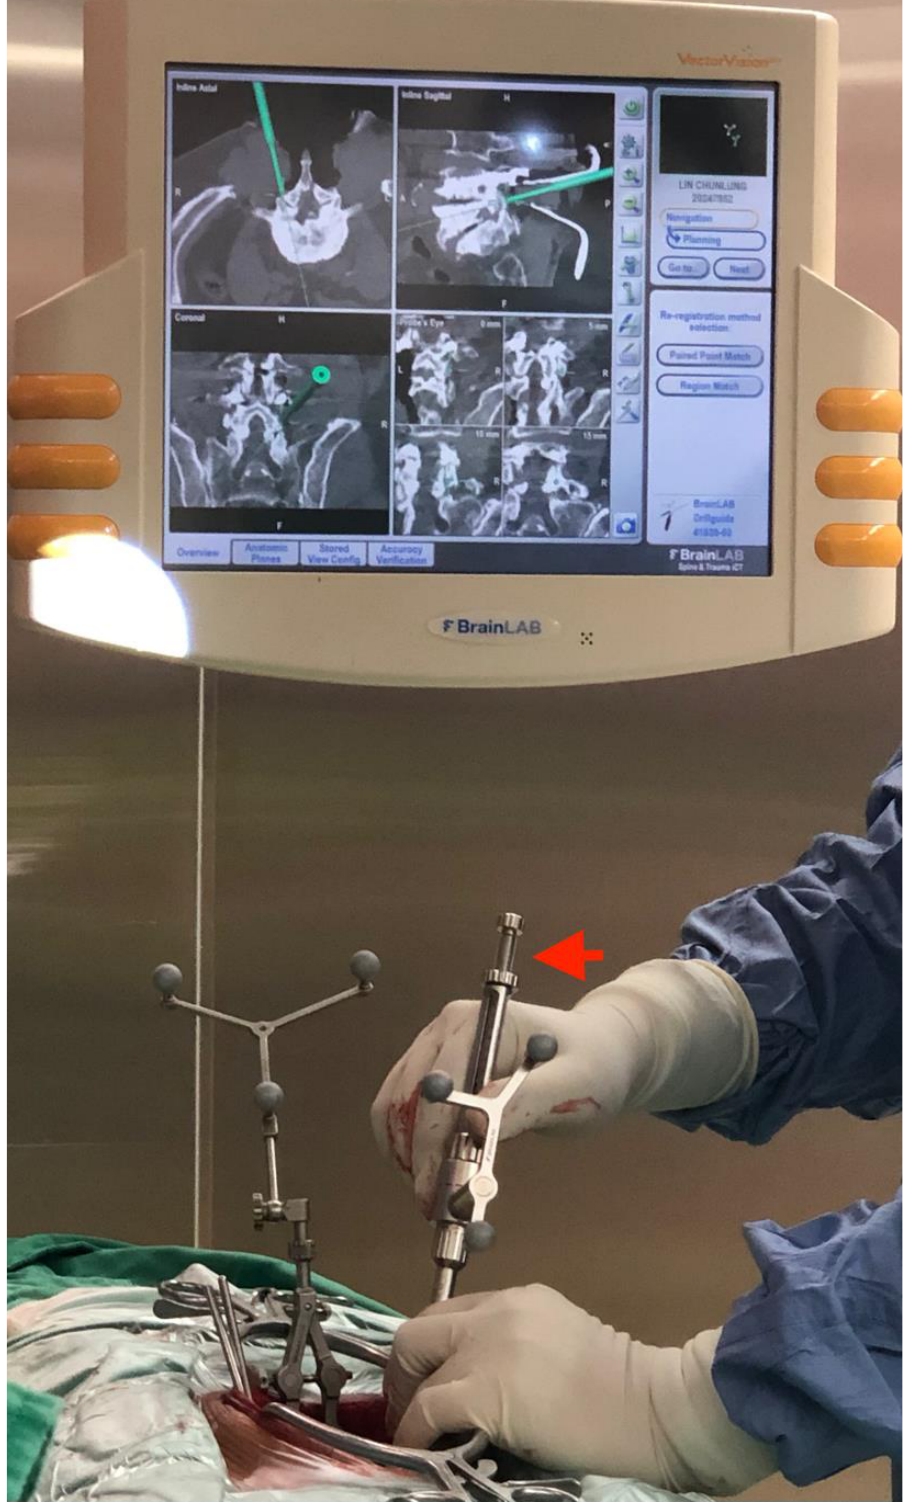
Figure 1. The straight drilling guide (red arrow) was used to guide a 2.7 mm in diameter drill bit to create the optimal TPS track under iCT-navigation by checking the axial, sagittal and coronal